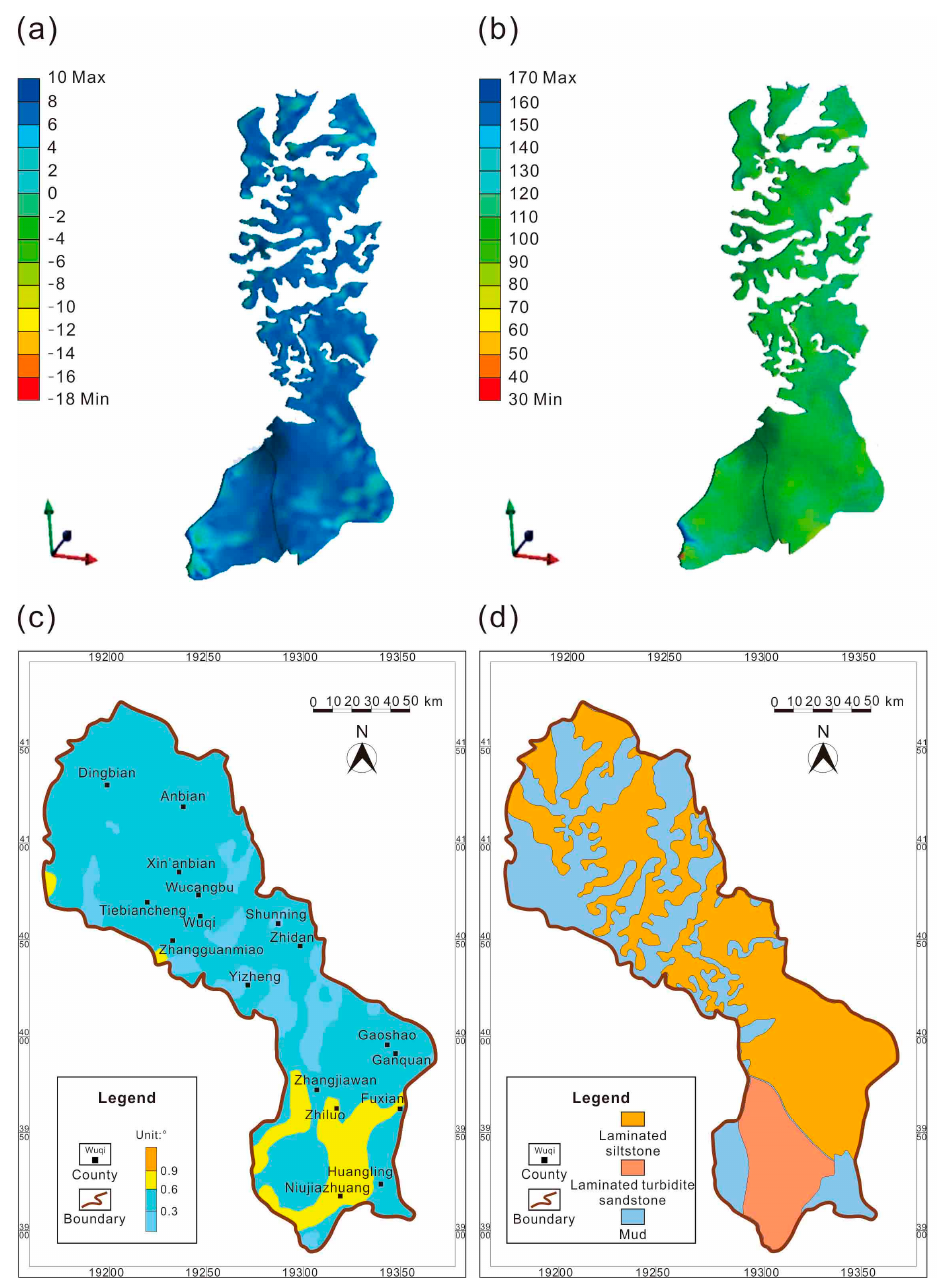
Figure 7. Calculation parameters used in the bedding fractures simulation. ( a , b ) Himalayan stress field during the Yanchang Formation simulated in Li et al. (2018) [14]; ( c ) stratigraphic dip map of tight reservoirs of Yanchang Formation; ( d ) lamina lithofacies distribution of tight reservoirs of Yanchang Formation.